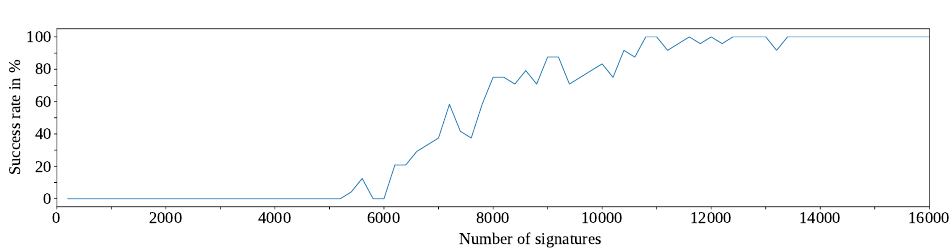
Figure 9: Success rate to recover an ECC key depending on number of